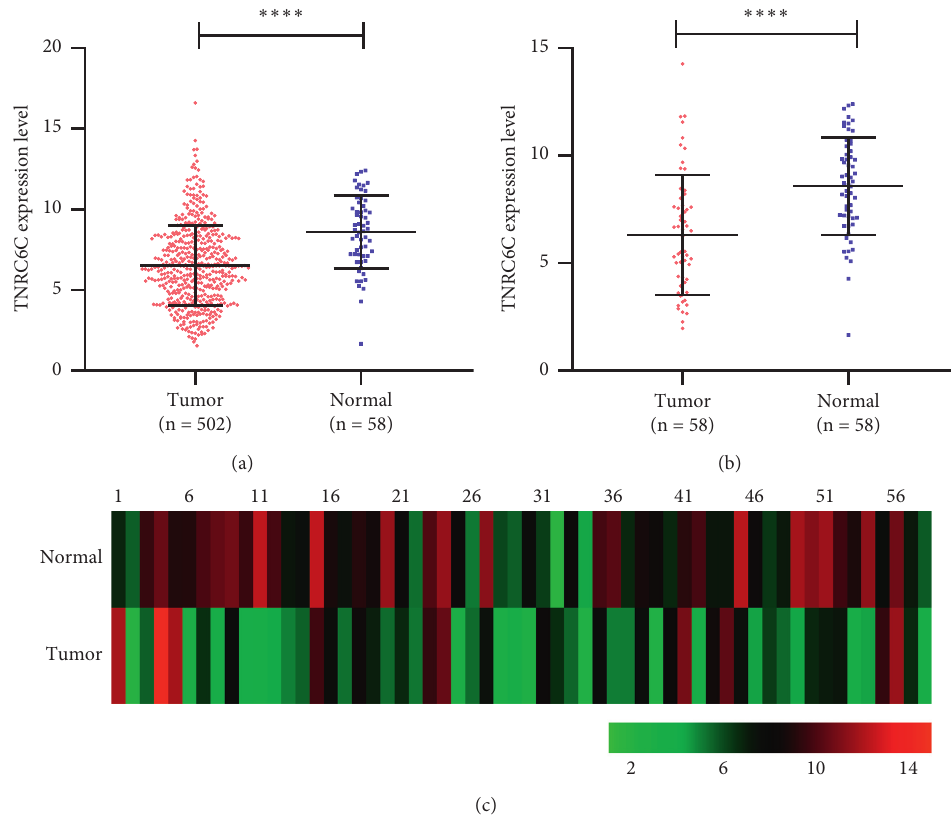
Figure 1: Differential mRNA expression of TNRC6C in PTCs and noncancerous thyroid tissues in TCGA database. (a) TNRC6C mRNA expression was significantly downregulated in PTC tissues ( n � 502) compared with the noncancerous tissues ( n � 58). (b) TNRC6C mRNA expression was significantly downregulated in 58 paired PTC tissues and their adjacent noncancerous tissues. (c) Heatmap of TNRC6C mRNA expression in 58 paired PTC tissues and their adjacent noncancerous tissues. TNRC6C mRNA expression was frequently downregulated in PTC tissues. ∗∗∗∗ P < 0 .